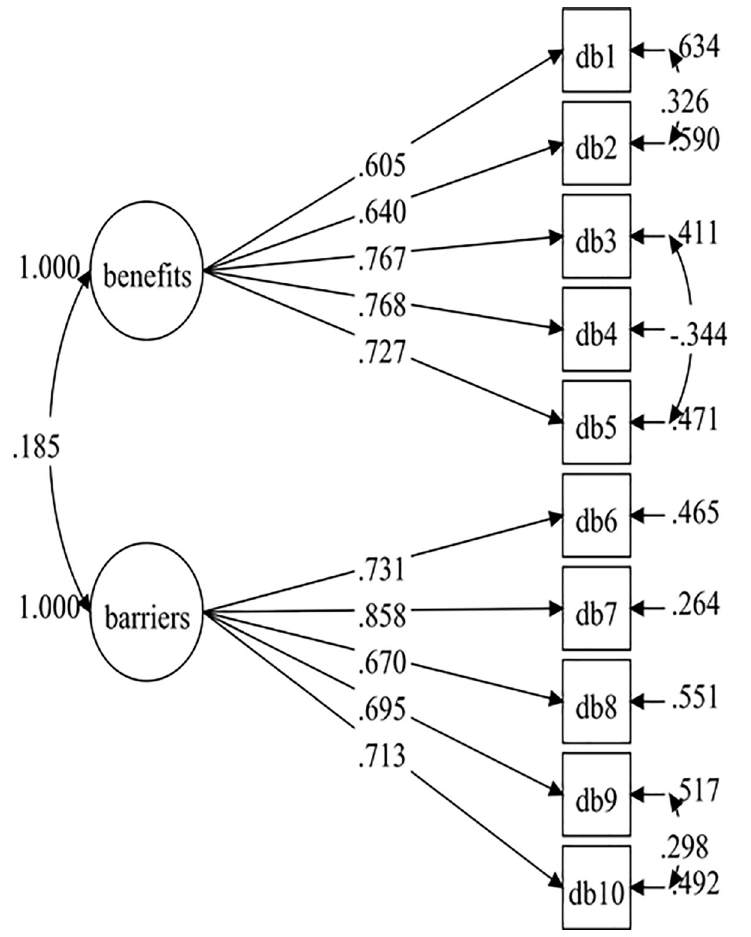
Fig 4. Female DB-M model